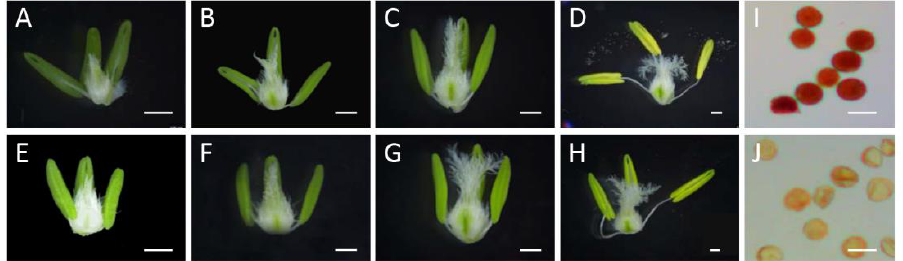
Figure 1. Anther phenotype and KI–I 2 staining in XN1376 ( A – D , I ) and XN1376-CIMS ( E – H , J ). ( A , E ) Eun, early uninucleate stage; ( B , F ) Lun, late uninucleate stage; ( C , G ) Bn, binucleate stage; ( D , H ) Tn, trinucleate stage; and ( I , J ) KI–I 2 staining. Scale bars are 1 mm in A – H and 50 µm in I , J .